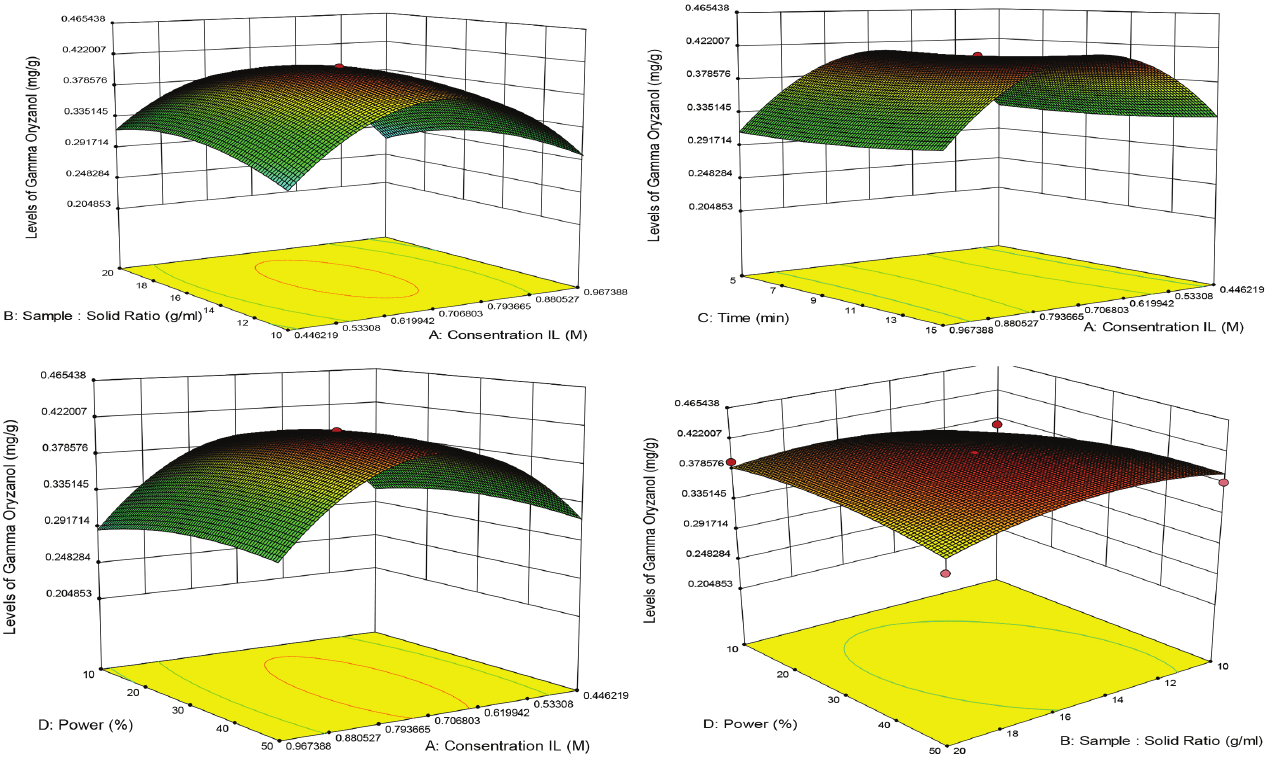
FIGURE 5 - The 3D response surface methodology (RSM)